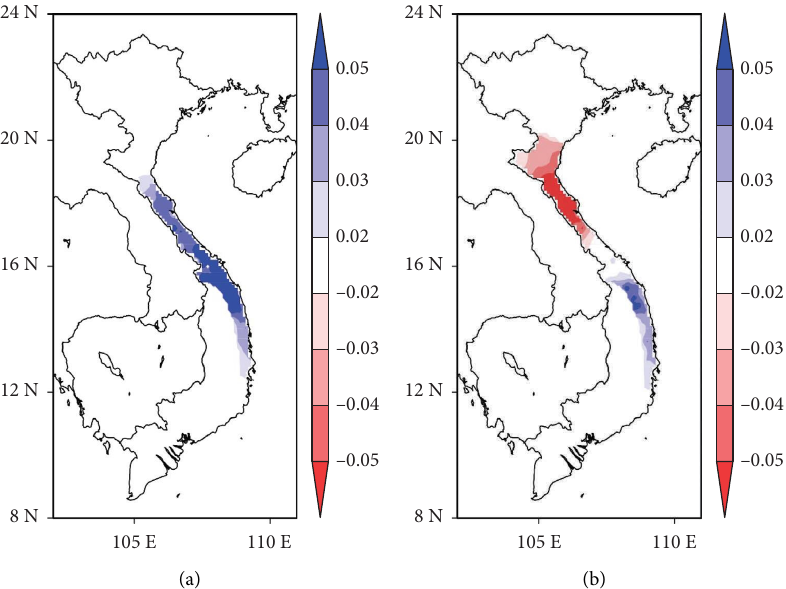
Figure 6: Te First two EOF modes of the fall rainfall in Vietnam in the period of 1981–2010. (a) EOF1(41%). (b)